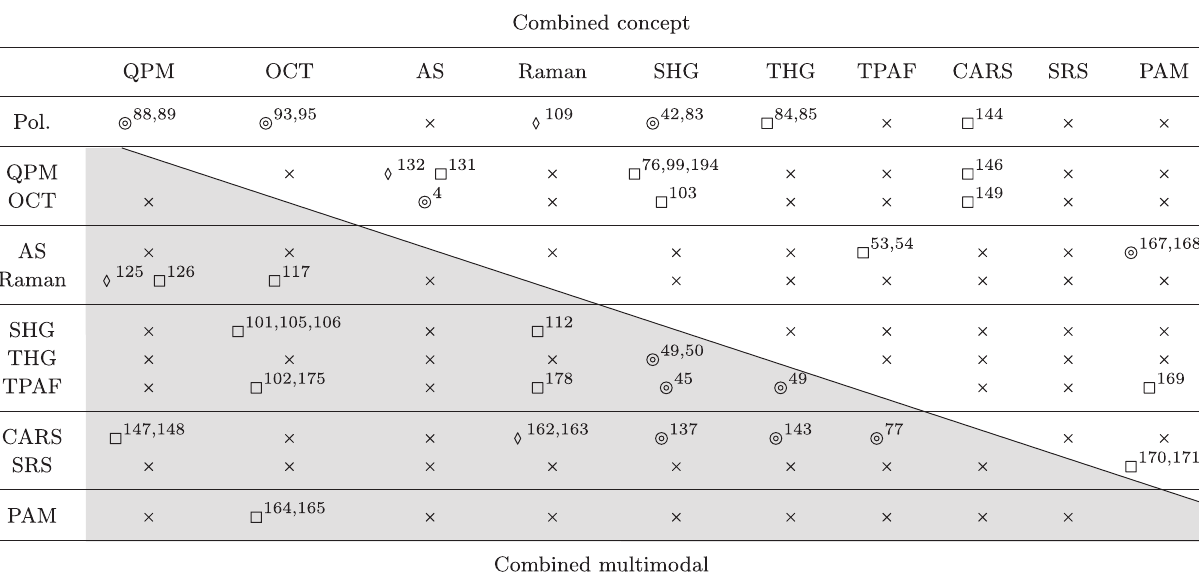
Table 1. Overview of current state of multimodal implementations. The table aims to show which modes have to date been combined and to what degree the multimodal combination was successful. The lower-left region of the table shows where the two modes were combined using simultaneous and independent measurement of both modes information. The upper-right part of the table shows where the two modes are multimodal in concept but do not provide two separate modes